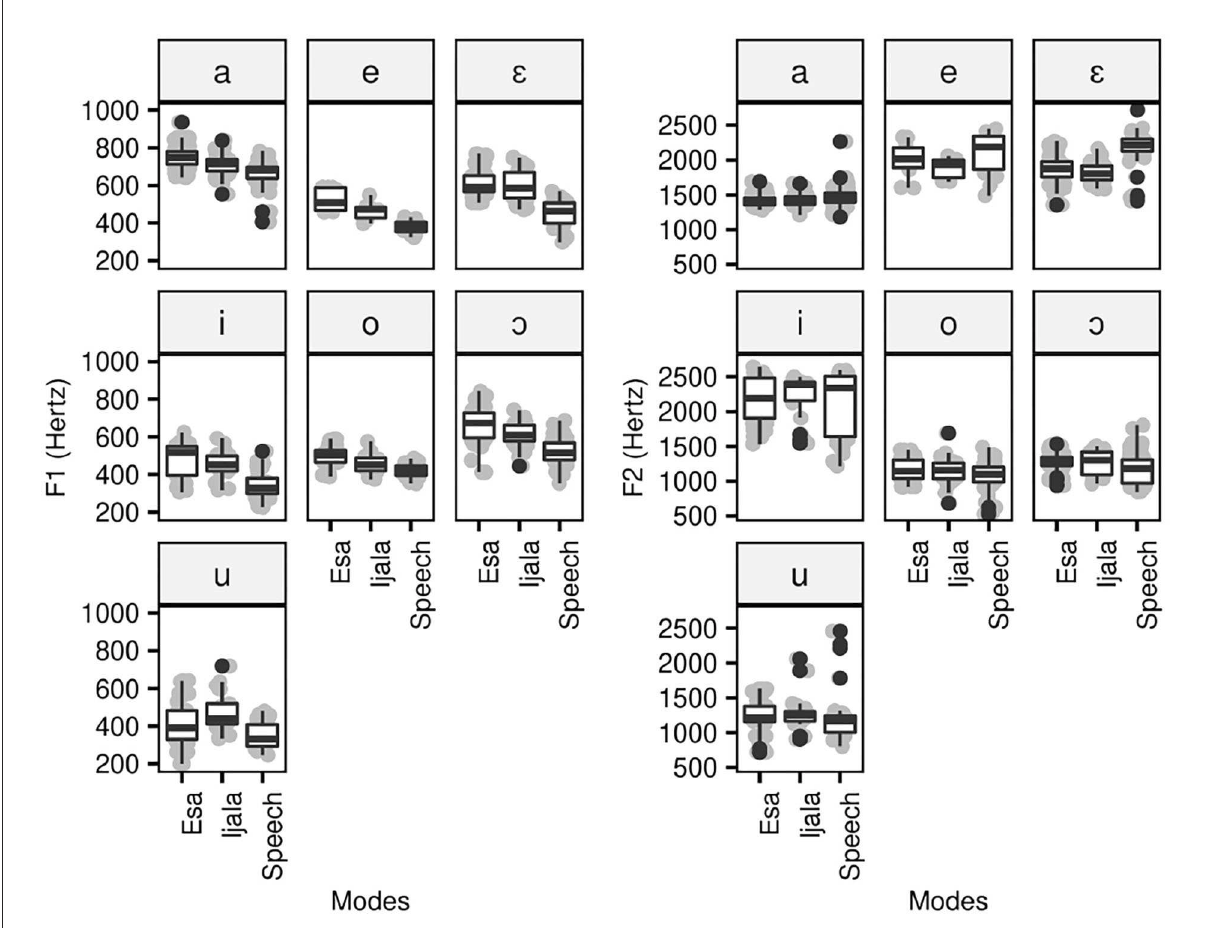
FIGURE8 Formant plots of oral vowels in poetic and speech